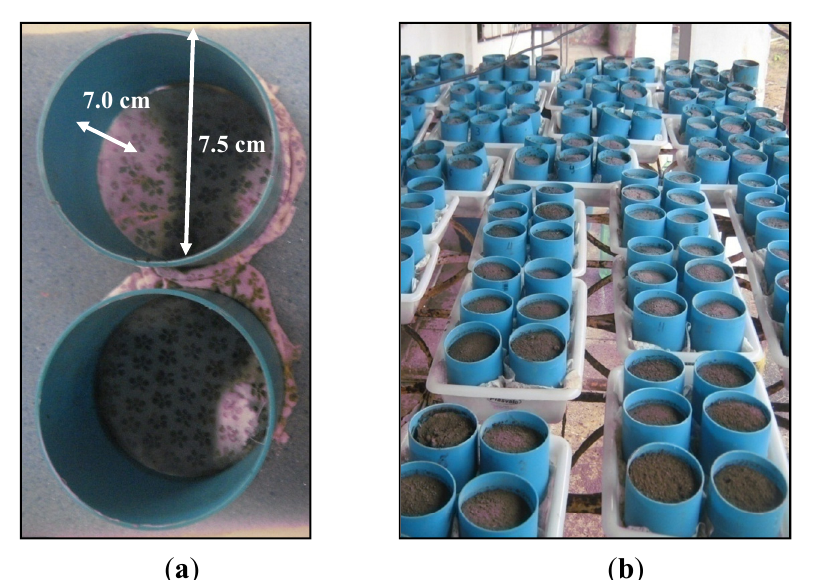
Figure 2. ( a ) The cylinders used in the experimental set-up with a sponge at the bottom; and ( b ) trays with six replications of soil samples per